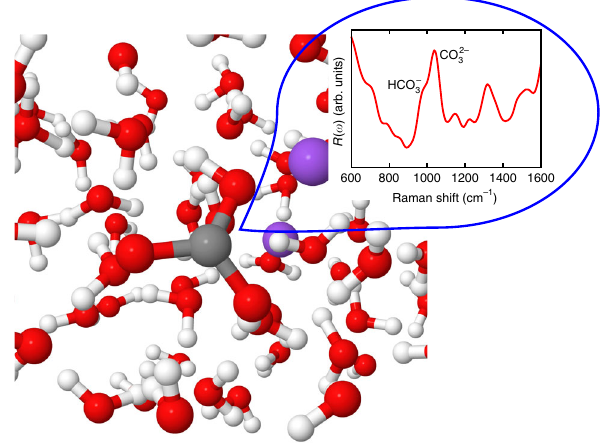
Fig. 1 A snapshot of the sodium carbonate solution at ~10 GPa and 1000 K. The con fi guration was selected from fi rst-principles molecular dynamics simulations trajectories (see text). The inset shows the calculated unpolarized Raman spectrum of the solution (red